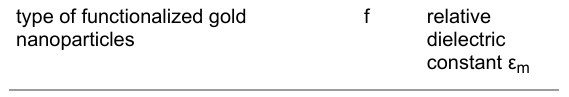
The results obtained so far can now be checked for consistency.